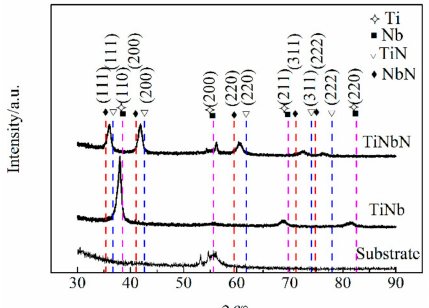
Figure 1. X-ray di ff raction (XRD) patterns for TiNb and TiNbN coatings on silicon wafers. The hatched lines indicate peak positions of selected materials. The peaks of cubic Ti and Nb are showed by coinciding